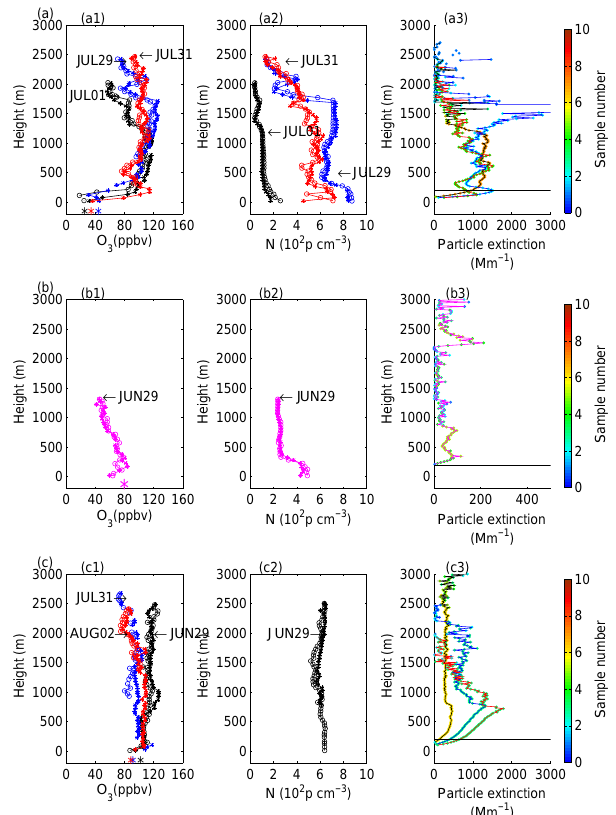
Figure 1. Vertical profiles of O 3 (a1, b1, c1) , aerosol number con- centration (a2, b2, c2) and particle extinction (a3, b3, c3) obtained in (a) early morning, (b) late morning, and (c) the afternoon, re- spectively. The O 3 and aerosol vertical profiles obtained during the ascent and descent of the UAV are indicated with circles and aster- isks, respectively. Ground-level O 3 mixing ratios during the flights are also shown together with the O 3 vertical profiles (bigger aster- isks with a negative offset in altitude). The color scales attached to particle extinction graphs (c1, c2, c3) show the sample numbers of individual particle extinctions, from which the averages of particle extinctions were calculated. The black lines indicate the altitude of 200m above ground, under which the particle extinction data should not be